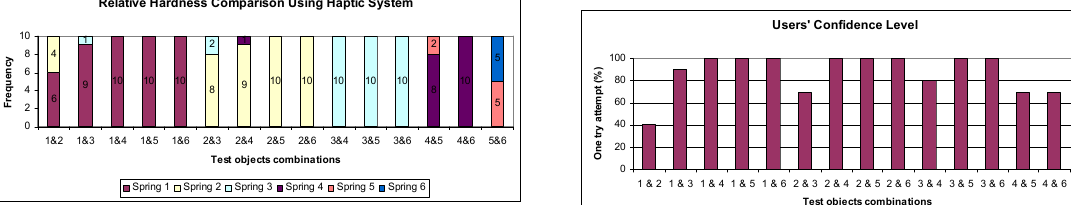
Fig. 10. Users’ confidence in comparing the test object combinations through the master-slave haptic gripper system. 5.3 E XP 3-T HE E FFECT OF T IME D ELAY ON THE P ERFORMANCE OF THE M ASTER -S LAVE H APTIC G RIPPER S